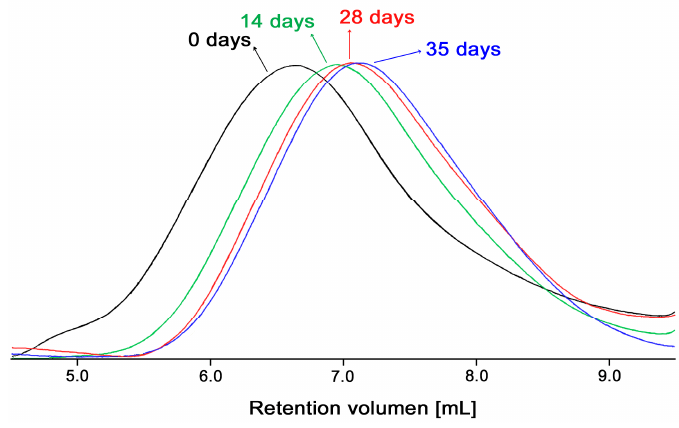
Figure 9. GPC chromatograms of chitosan stored at 50 °C for 0, 14, 28 and 35 days.